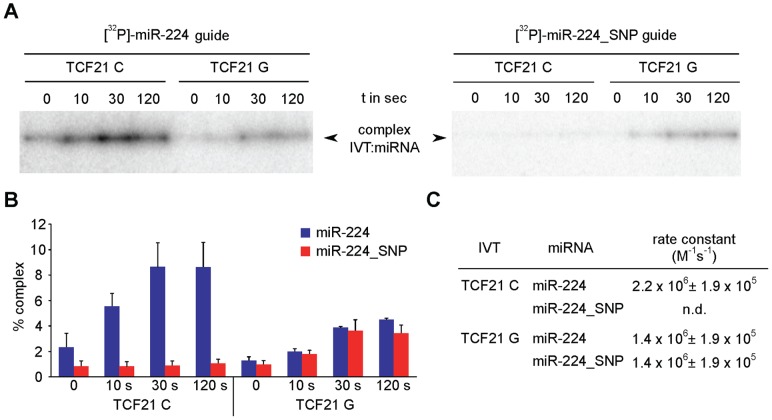

In vitro annealing kinetics between miR-224 and TCF21 3′UTR variants.(A) (Left panel) TCF21 3′-UTR variants were generated by in vitro transcription (IVT) and incubated with excess over 32P-labeled miR-224 for various time points, followed by autoradiography detection. Band intensities indicate relative amounts of the 3′-UTR variant:miRNA complexes formed over indicated times. (Right panel) IVT 3′-UTR variants were also incubated with excess over 32P-labeled miR-224_SNP, resulting in a seed mismatch with the C variant and a seed match with the G variant. (B) Band intensities of 3′-UTR:miRNA complexes formed using 32P-labeled miR-224 or 32P-labeled miR-224_SNP were detected by PhosphorImager and to quantify the percentage of complex signals ImageQuant-Software was used to determine relative to whole lane signal. Values represent mean ± SEM from three independent experiments. (C) Calculation of second-order rate constants for individual mRNA:miRNA complexes was performed as previously described [54]. n.d., complex formation was too slow to derive a rate constant.